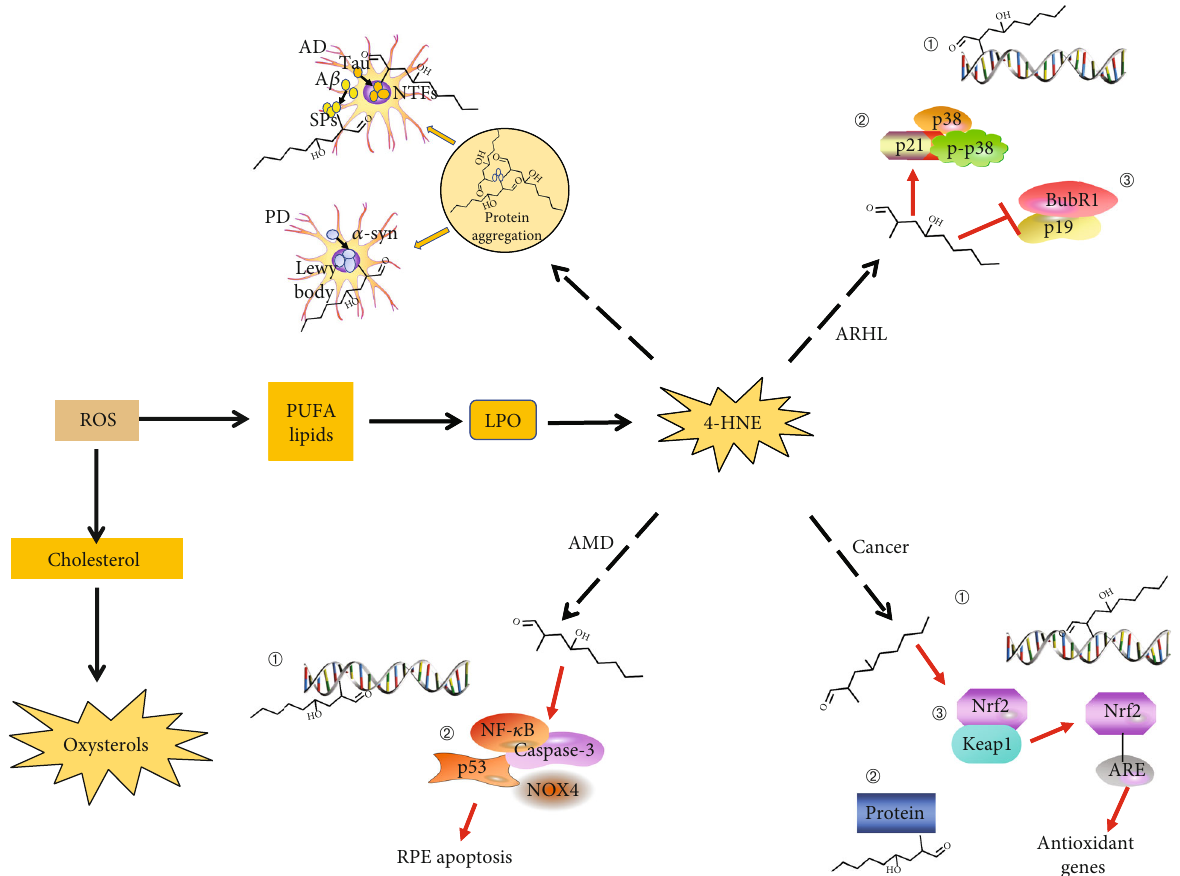
Figure 3: Role of 4-HNE in aging-related diseases. AD and PD: 4-HNE induces protein aggregation, abnormal aggregates of A β forms SP, and hyperphosphorylation of tau protein to form NFTs, which eventually leads to AD; aggregates of α -synuclein form Lewy body-like inclusions leading to PD. ARHL: 4-HNE (1) causes DNA damage; (2) increases p21, p38, and p-p38 activity; (3) reduces p19 and